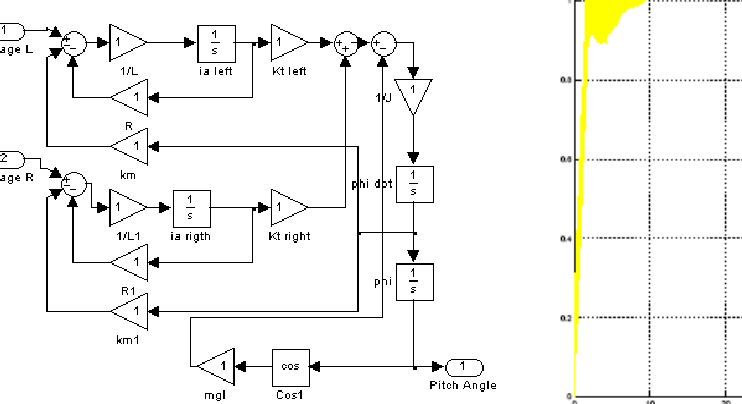
Fig. 4. Pitch Angle versus time with range